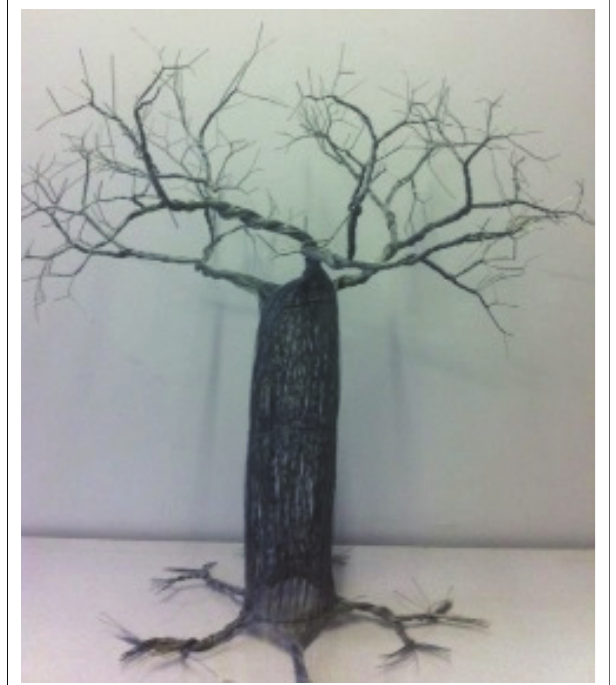
FIGURE 5: Example of